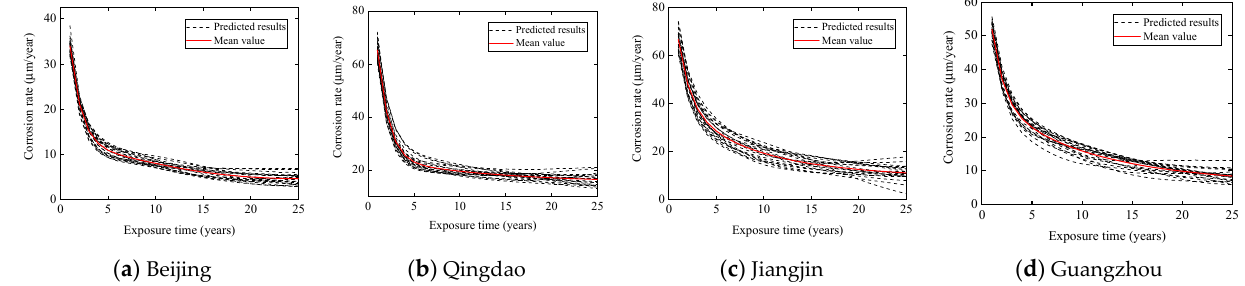
Figure 16. Predicted results of the Q235 steel corrosion rate.